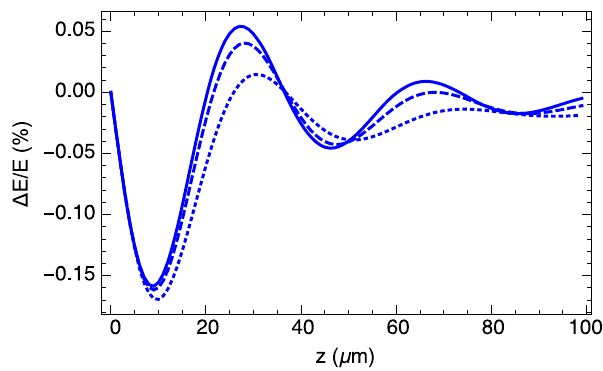
FIG. 6. Relative energy change for three values of RRR, for Al: the solid line is for RRR ¼ 100 , the dashed line is for RRR ¼ 10 , and the dotted line is for RRR ¼ 3